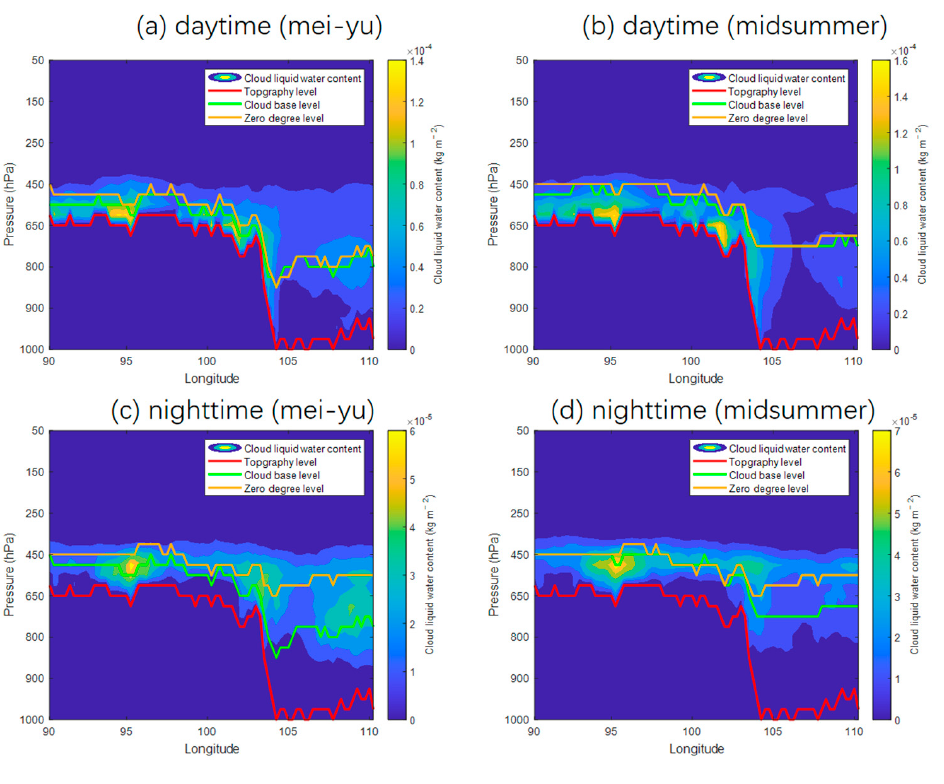
Figure 5. The pressure level of cloud liquid water content (shaded color), cloud base (green line), zero degree level (orange line), and the topography (red line) along with longitude during the ( a , b ) mei-yu and ( c , d ) midsummer periods during the ( a , c ) daytime and ( b , d ) nighttime.